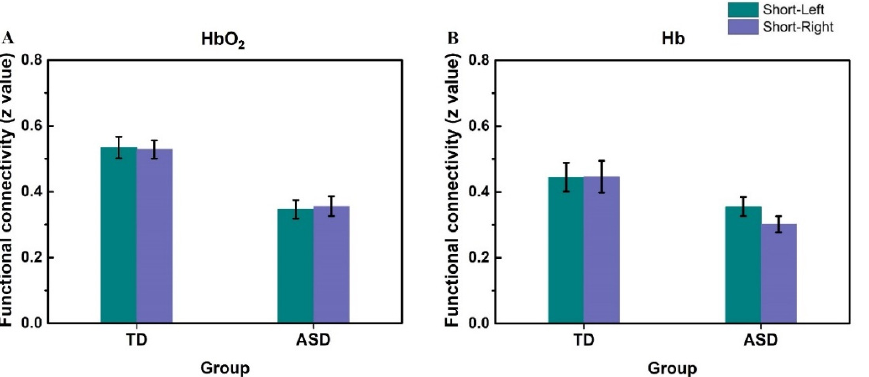
Figure 3. The average of short ‐ range RSFC at two hemispheres for HbO 2 ( A ) and Hb ( B ) for ASD and TD groups. Short ‐ Left: the short ‐ RSFC on the left hemisphere. Short ‐ Right: the short ‐ RSFC on the right hemisphere. The error bar is the standard error of the mean. For HbO 2 ‐ RSFC, in the TD group, the z ‐ value was 0.53 ± 0.03 for Short ‐ Left, and 0.53 ± 0.03 for Short ‐ Right; while in the ASD group, the z ‐ value was 0.35 ± 0.03 for Short ‐ Left, and 0.36 ± 0.03 for Short ‐ Right. For Hb ‐ RSFC, in the TD group, the z ‐ value was 0.44 ± 0.04 for Short ‐ Left, and 0.45 ± 0.05 for Short ‐ Right, while in the ASD group, the z ‐ value was 0.36 ± 0.03 for Short ‐ Left, and 0.30 ± 0.02 for Short ‐ Right. In each group, there was no significant difference between the left and right hemispheres in short ‐ RSFC for either HbO 2 or Hb.